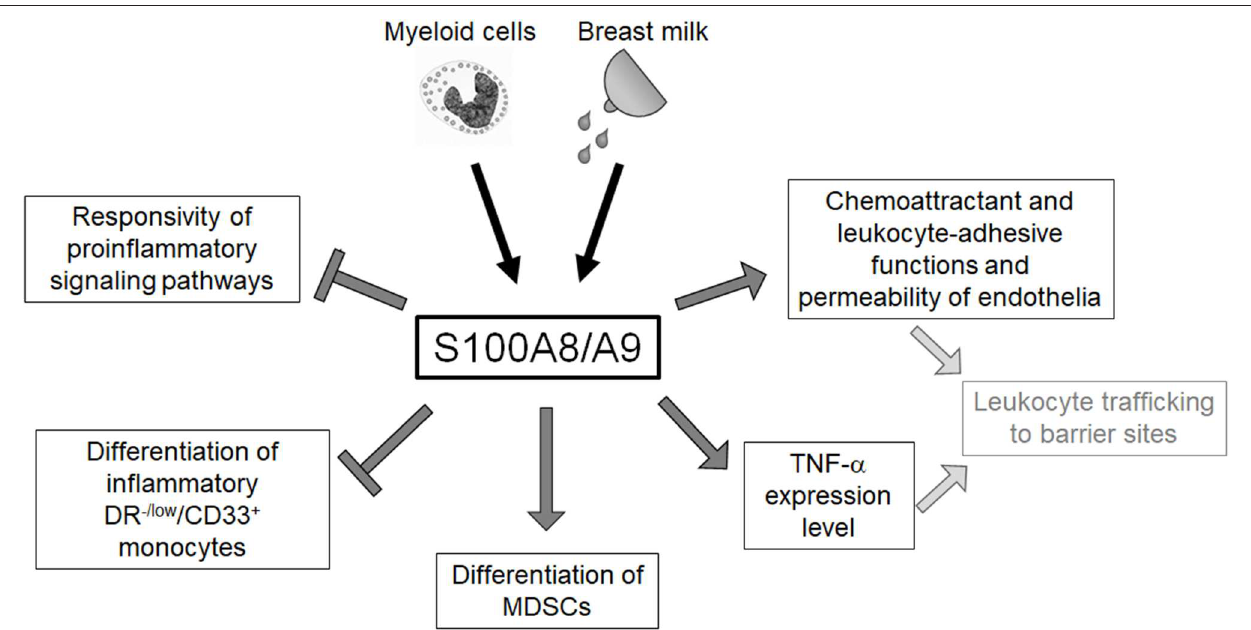
FIGURE 2 | Overview of the regulatory impact of S100A8/A9 on the neonatal innate immune system. Neonatal blood monocytes and breast milk are sources of S100A8/A9 that contribute to the high serum levels of these alarmins in newborn infants. S100A8/A9 constrains systemic inflammatory responses of neonates by tolerizing innate signaling pathways and regulating the expansion of inflammatory and anti-inflammatory myeloid subpopulations. S100A8/A9 impacts directly and indirectly on the leukocyte-recruiting functions of the vascular endothelium S100A8/A9 which suggests an important role in warranting the essential postnatal trafficking of leukocytes to barrier